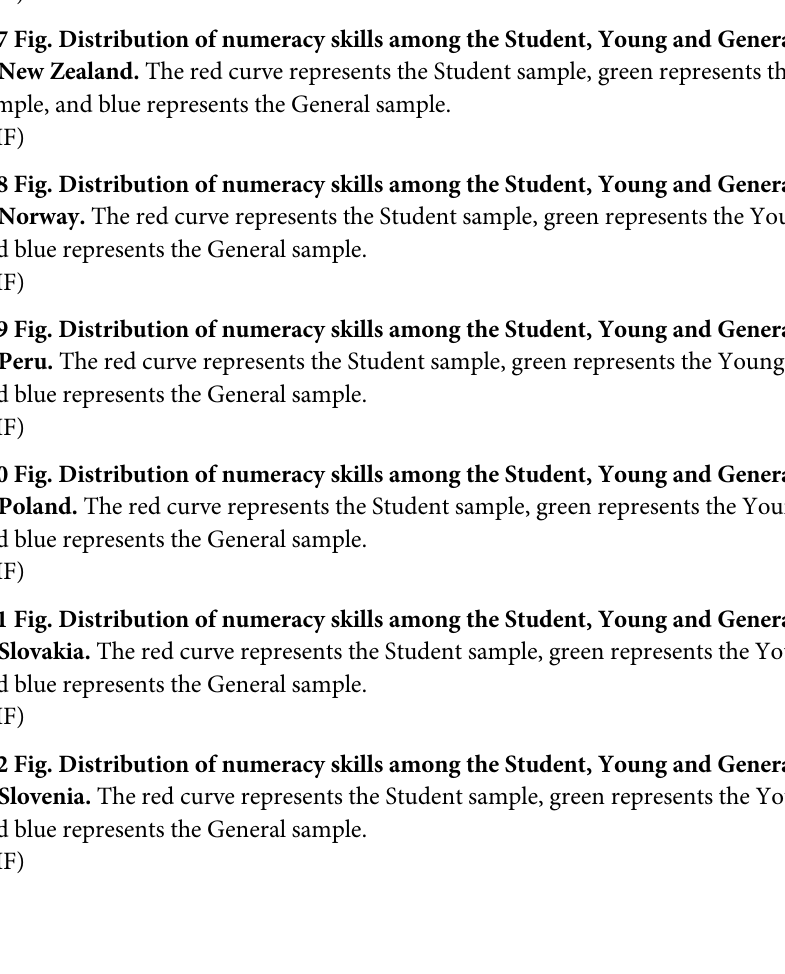
Sample, and blue represents the General sample. (TIF) S53 Fig. Distribution of numeracy skills among the Student, Young and General samples of Korea. The red curve represents the Student sample, green represents the Young Sample, and blue represents the General sample. (TIF) S54 Fig. Distribution of numeracy skills among the Student, Young and General samples of Lithuania. The red curve represents the Student sample, green represents the Young Sam- ple, and blue represents the General sample. (TIF) S55 Fig. Distribution of numeracy skills among the Student, Young and General samples of Mexico. The red curve represents the Student sample, green represents the Young Sample, and blue represents the General sample. (TIF) S56 Fig. Distribution of numeracy skills among the Student, Young and General samples of Netherlands. The red curve represents the Student sample, green represents the Young Sample, and blue represents the General sample. (TIF) S57 Fig. Distribution of numeracy skills among the Student, Young and General samples of New Zealand. The red curve represents the Student sample, green represents the Young Sample, and blue represents the General sample. (TIF) S58 Fig. Distribution of numeracy skills among the Student, Young and General samples of Norway. The red curve represents the Student sample, green represents the Young Sample, and blue represents the General sample. (TIF) S59 Fig. Distribution of numeracy skills among the Student, Young and General samples of Peru. The red curve represents the Student sample, green represents the Young Sample, and blue represents the General sample. (TIF) S60 Fig. Distribution of numeracy skills among the Student, Young and General samples of Poland. The red curve represents the Student sample, green represents the Young Sample, and blue represents the General sample. (TIF) S61 Fig. Distribution of numeracy skills among the Student, Young and General samples of Slovakia. The red curve represents the Student sample, green represents the Young Sample, and blue represents the General sample. (TIF) S62 Fig. Distribution of numeracy skills among the Student, Young and General samples of Slovenia. The red curve represents the Student sample, green represents the Young Sample, and blue represents the General sample.